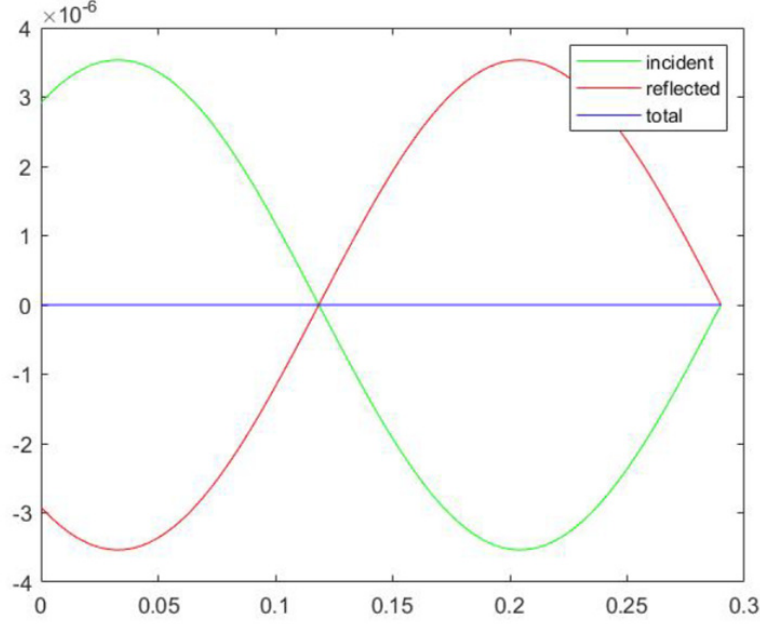
Figure 9. Sound pressure reconstructed inside the impedance tube for the passive case at f = 1000 Hz: